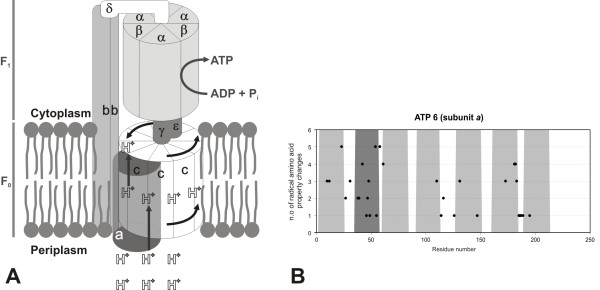
Rotary model for E. coli F1F0 ATPase and variation in the mammalian ATP6 subunit. A) Rotary model for E. coli F1F0 ATPase (see text for details); B) Topological assignment of the sites that present a high number of strong positively selected amino acid properties under positive-destabilizing selection in ATP6 (corresponds to the a subunit in E. coli). The transmembrane domains location is shown in grey (for details see Material and Methods section). The dark grey domain was only predicted by one of the three methods used.